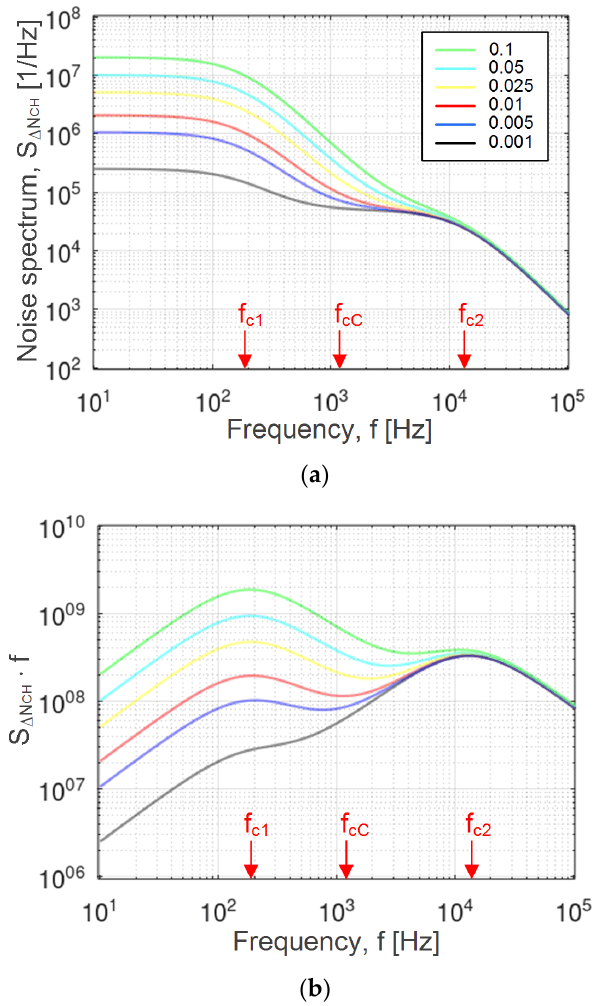
Figure 1. ( a ) Noise spectrum, i.e., the power spectral density of fluctuations in the number of electrons included in the charge transfer between the adsorbed CO 2 molecules and the heterogeneous sensing material, for various ratios v of the number of adsorption sites on the edges and the number of basal plane sites of LPE graphene. ( b ) The same quantity multiplied by the frequency f , thus making the spectrum characteristic features more distinguishable. The characteristic frequencies of the spectrum are shown for the case v = 0.01 (red curve).